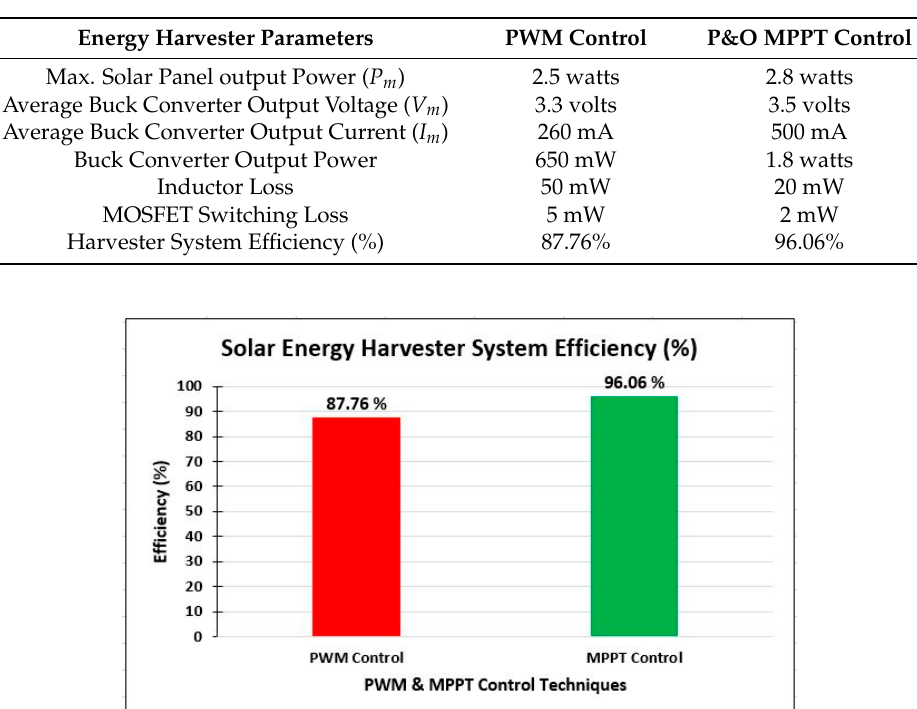
Table 2. Simulation Results for PWM and MPPT Controlled SEH systems.